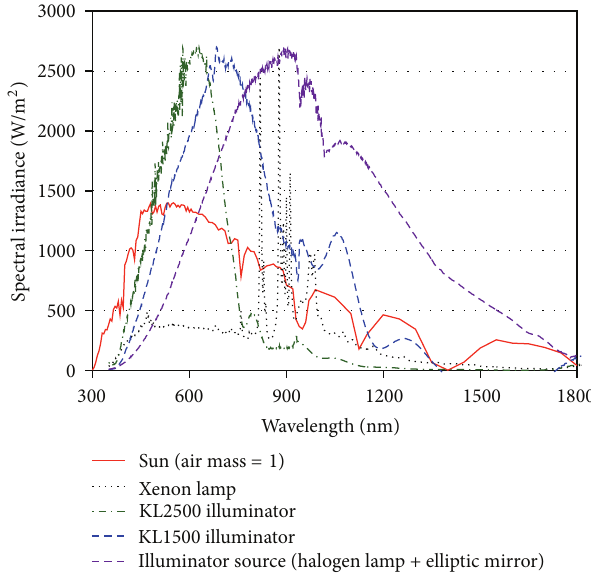
Figure10:Lamplight(measuredwithintegratingsphere)compared to the sunlight.